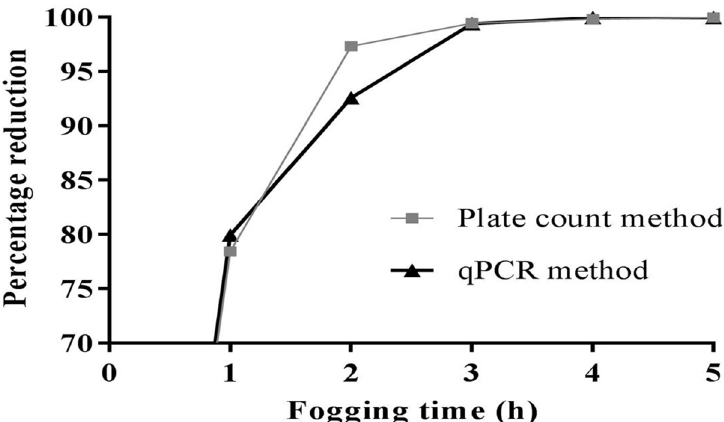
Fig 8. Percentage of killed bacteria enumerated using plate count and quantitative PCR